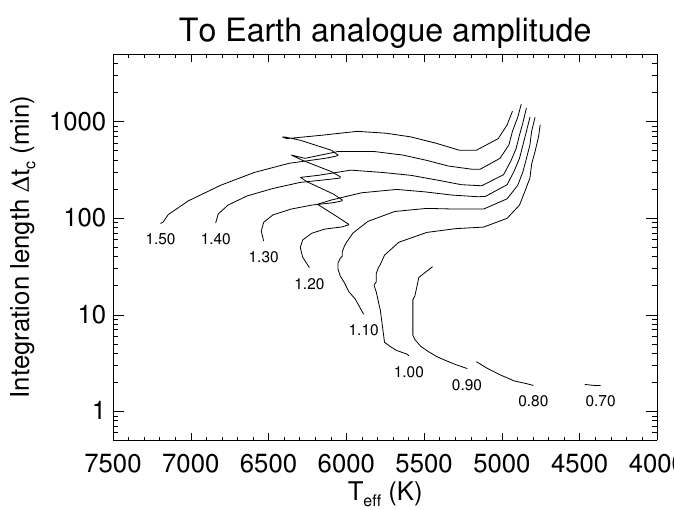
Figure 9. A subset of Figure 5 from [82], showing the exposure lengths required to reduce oscillation noise to a level sufficient for the detection of an Earth-mass planet in the habitable zone of stars along various evolutionary tracks, from 0.7–1.5 M. c (cid:13) AAS. Reproduced with